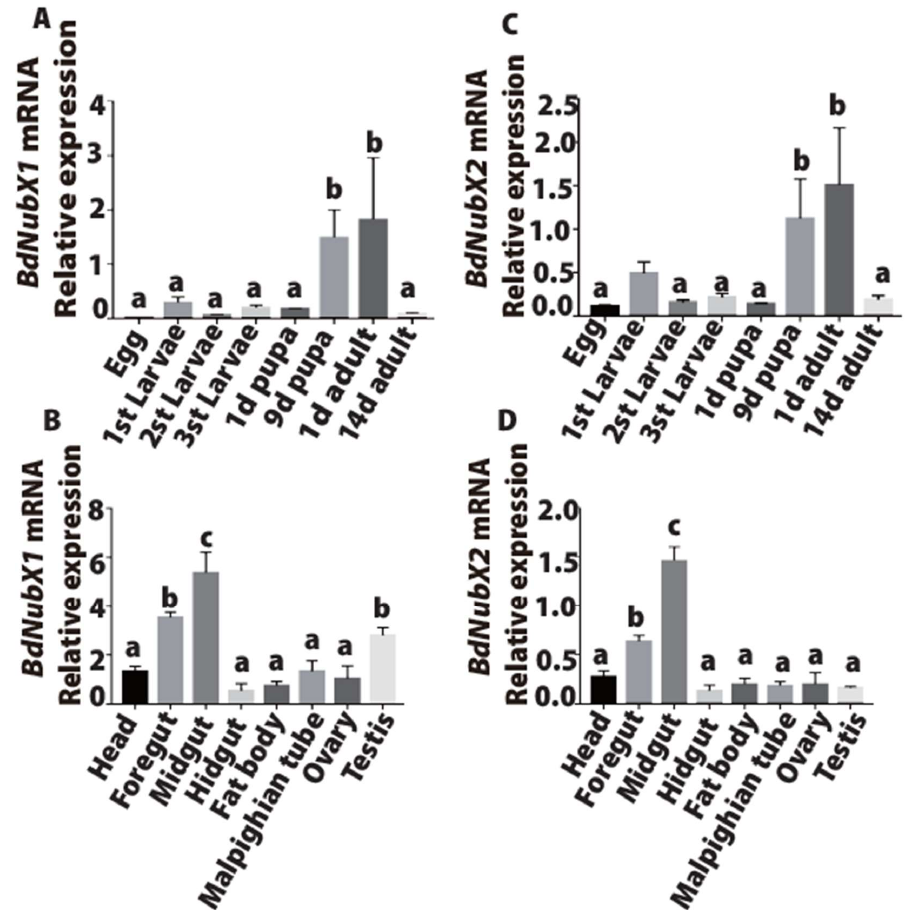
Figure 2. Expression profiles of BdNubX1 and BdNubX2. ( A ) : BdNubX1 Expression profile of differ- ent development stages, 20 different stage of development samples per biological replicate, three biological replicates. ( B ) : BdNubX1 expression profile of different adult tissues, 30 different tissue samples per biological replicate, three biological replicates. ( C ) : BdNubX2 Expression profile of dif- ferent development stages, 20 different stage of development samples per biological replicate, three biological replicates. ( D ): BdNubX2 expression profile of different tissues of adults. Different letters indicate statistically significant differences in BdNub isoforms expression, 30 different tissue samples per biological replicate, three biological replicates. p < 0.05, Tukey’s test, One way ANOVA. 3.3. BdNub Does Not Participate in Systemic Infection of the IMD Pathway Next, we examined BdNubX1 and BdNubX2 expression at different time points after E. coli systemic infection. E. coli is a gram-negative pathogen that can elicit a robust im- mune response in B.dorsalis . The results showed that the BdNubX1 transcript had no sig- nificant increase after systemic infection with E. coli (Figure 3A). Similarly, the BdNubX2 transcript showed no significant change after E. coli infection (Figure 3B). These results indicated that BdNub did not play a role in the systemic infection of Gram-negative E. coli . To strengthen our conclusion, we further detected the main immune effectors of the IMD pathway, including AMPs Dpt , Cec , AttA , AttB , and AttC . The results showed that all five AMPs were significantly up-regulated at 3 h, 6 h, and 12 h after E. coli infection, proving that systemic infection works well in B. dorsalis (Figure 3C–E).